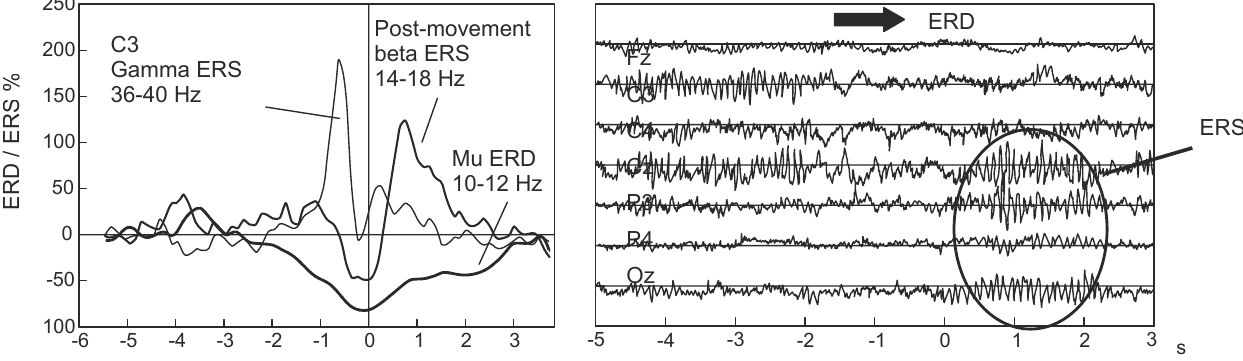
Figure 2. Left panel : Superimposed band power time courses computed for three different frequency bands (10–12 Hz, 14–18 Hz, and 36–40 Hz) from EEG trials recorded from electrode position C3 during right index finger lifting. EEG data triggered with respect to movement-offset (vertical line at t = 0 s); Right panel : Examples of ongoing EEG recorded during right finger movement (adapted from